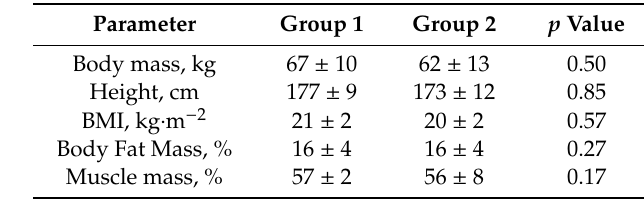
Table 2. Anthropometric characteristics and body composition in Group 1 and